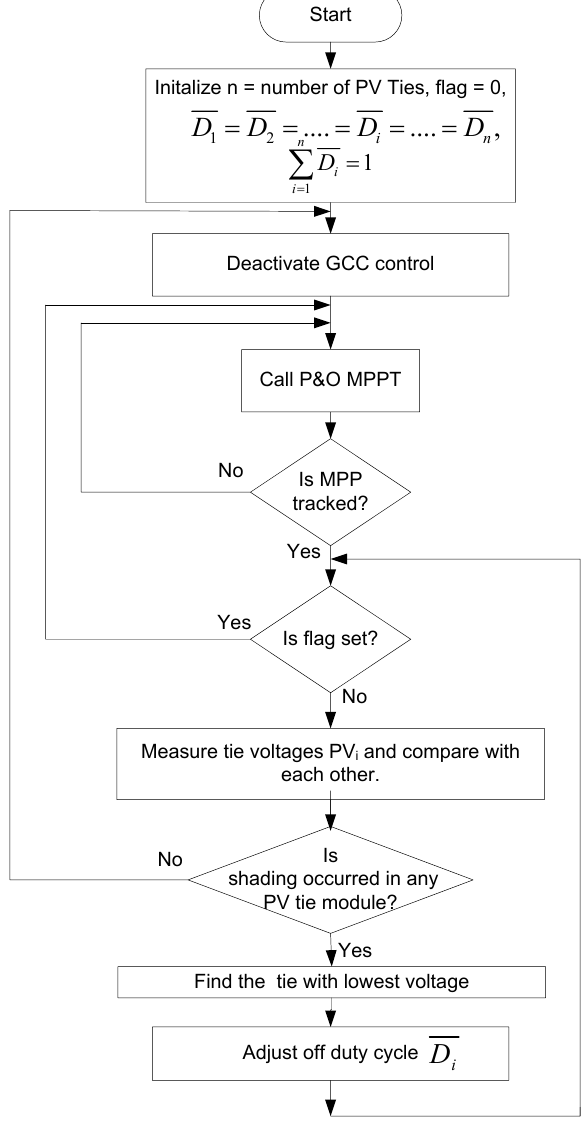
Fig 4. Algorithm of TCT-GCC technique for MPPT.